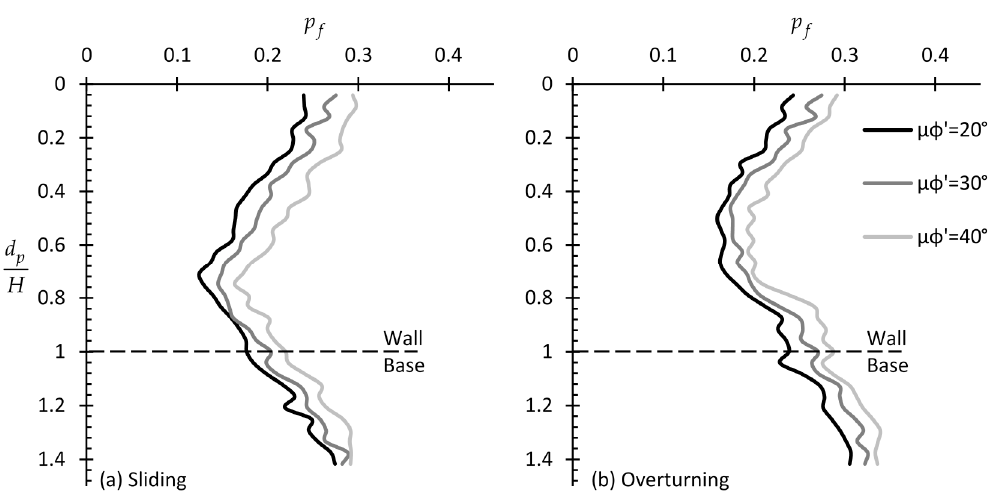
Figure 8. p f − d p / H curves for x / H = 0.5, θ / H = 2.08 and di ff erent µ φ (cid:48) values for the ( a ) sliding and ( b ) overturning modes of failure. = Figure 8. f p - p d H curves for x H 0.5, H θ = 2.08 and different ' φ μ values for the ( a ) sliding and ( b ) overturning modes of failure.